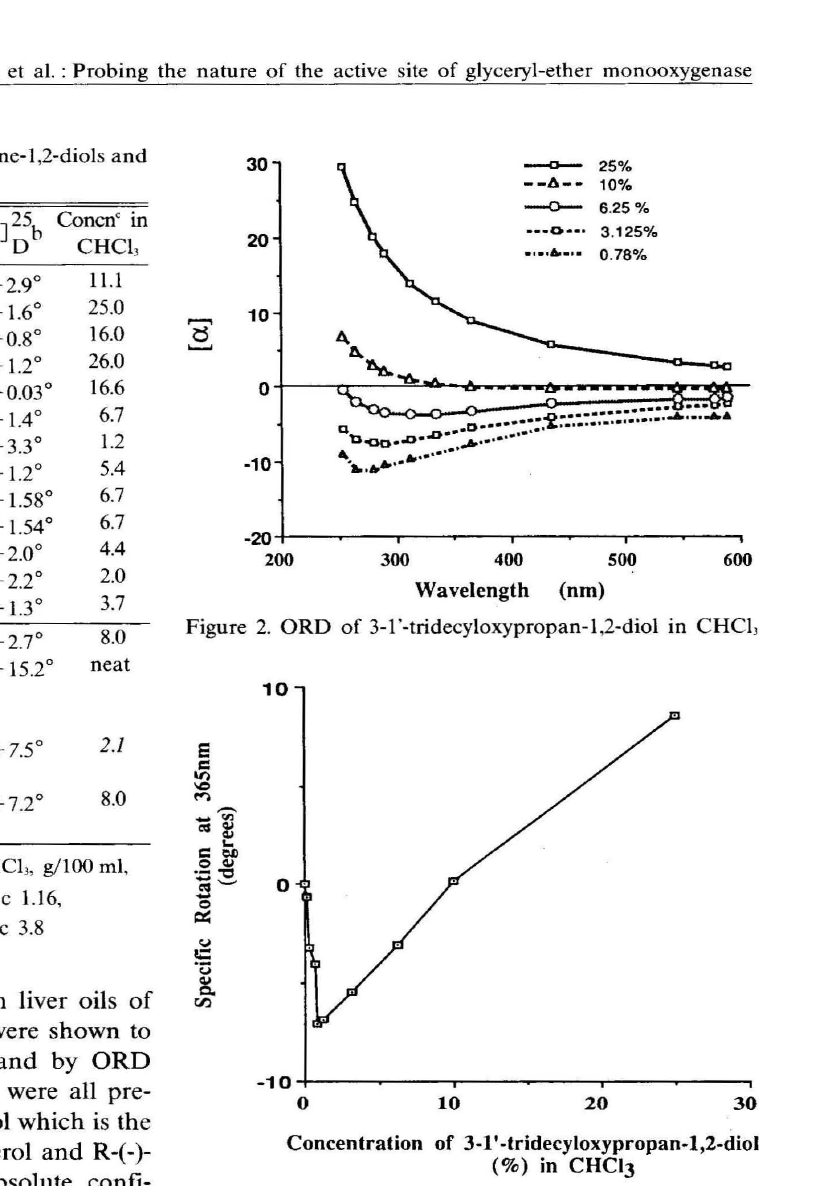
Table 3. Sepcific Rotations of3-Alkoxypropane-I,2-diols and